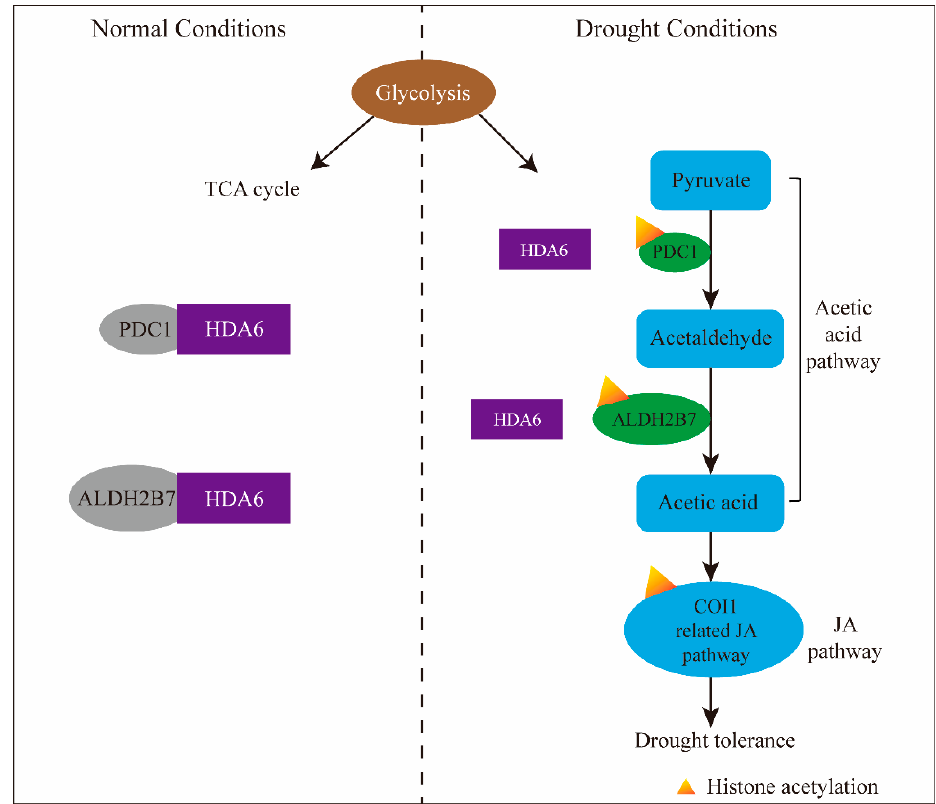
Figure 4. A model of HDA6-mediated glycolysis-acetic acid-JA drought response signaling path- way.